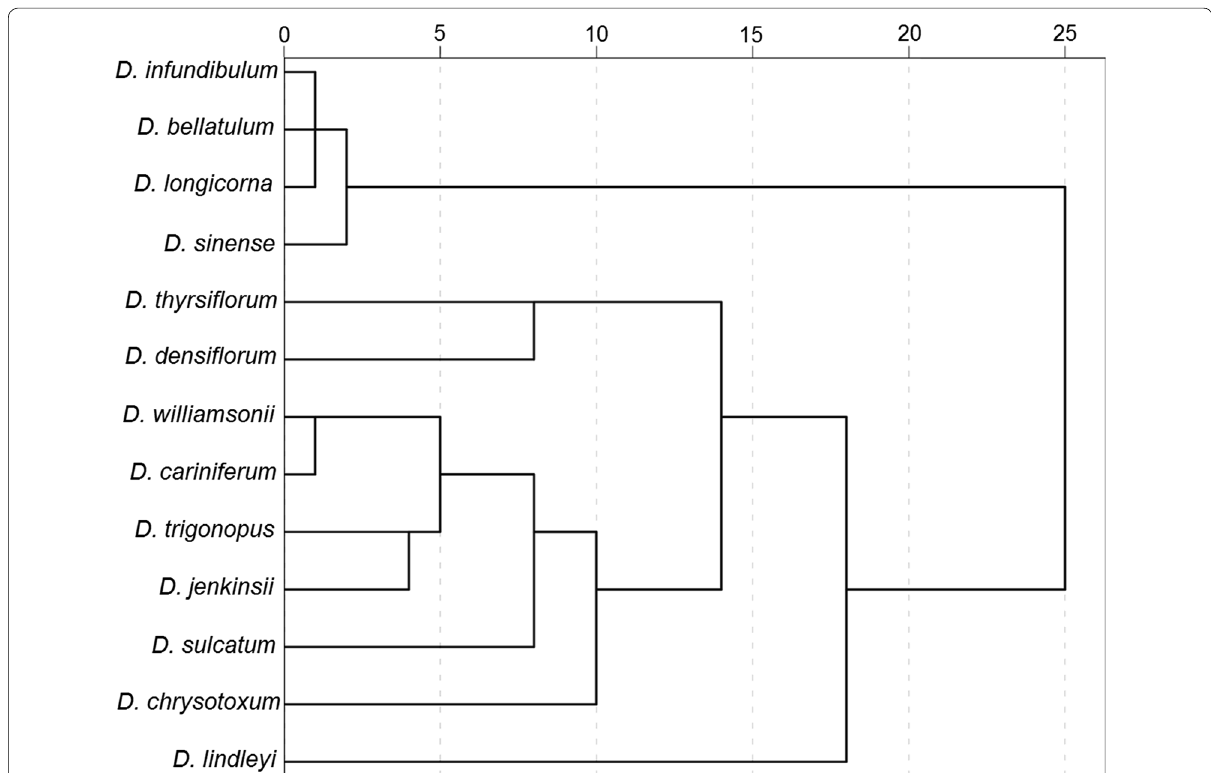
Fig. 4 Dendrogram of hierarchical cluster based on the angle among Helix I, II, III and IV, the length of Helix I, II, III and IV, and the number of Loop in Helix I, II, III and